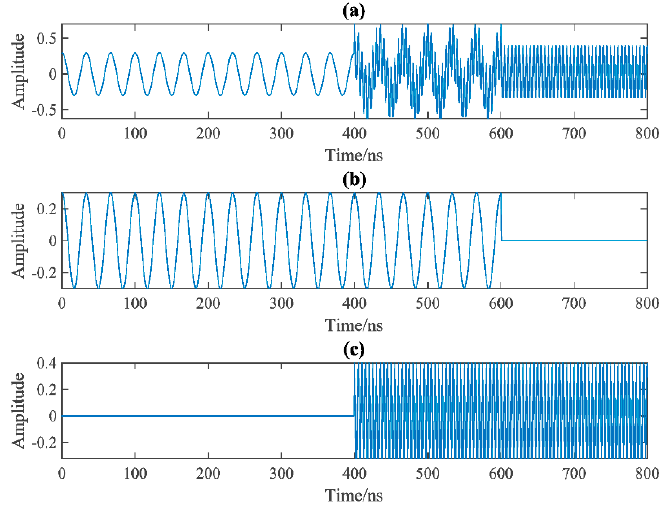
Figure 1. The first channel of the synthetic benchmark (channel-1) ( a ) composed of two sub-components ( b , c ).